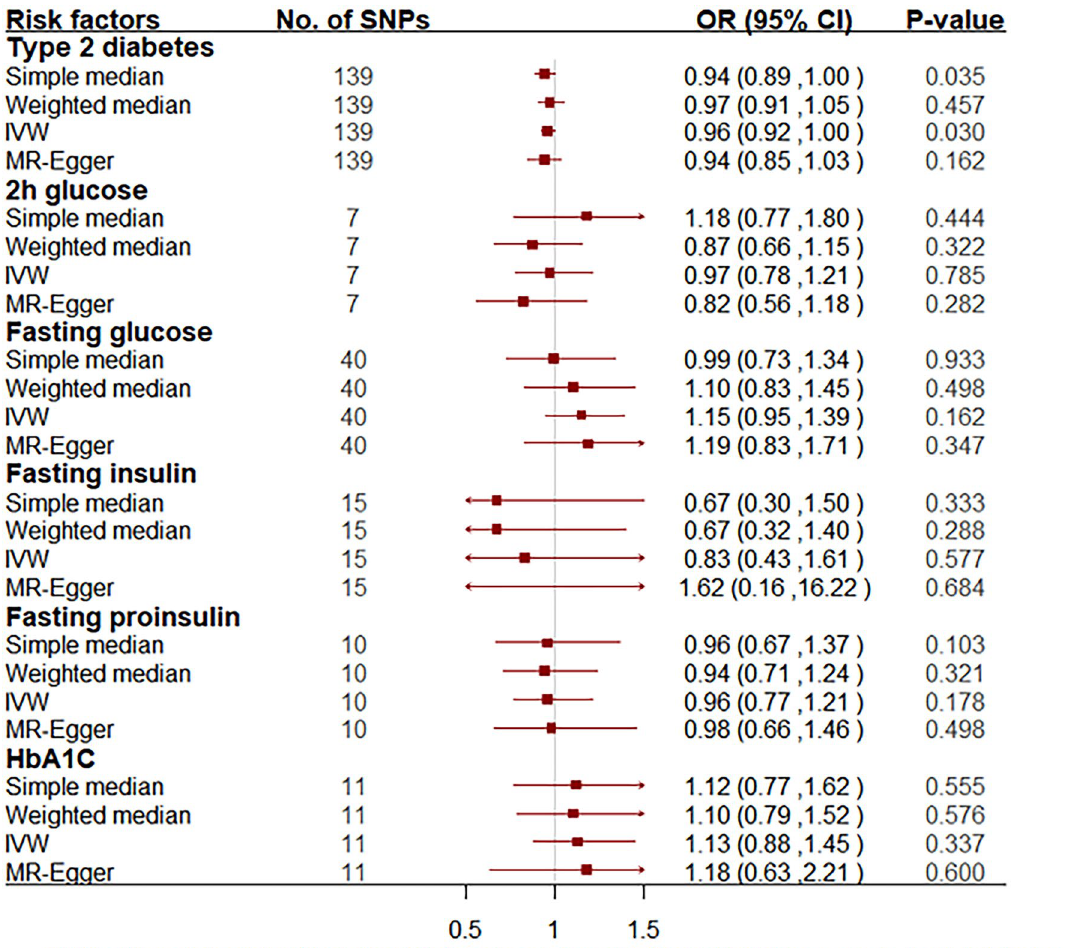
Figure 3. Odds ratio for association between genetically predicted T2D and related traits and ALS in European populations. Squares represent the odds ratio of amyotrophic lateral sclerosis per genetically predicted 1 SD increase in T2D; horizontal lines represent 95% confidence intervals (CIs). SNPs single nucleotide polymorphisms, OR odds ratio, IVW inverse variance weighted, HbA1C hemoglobin